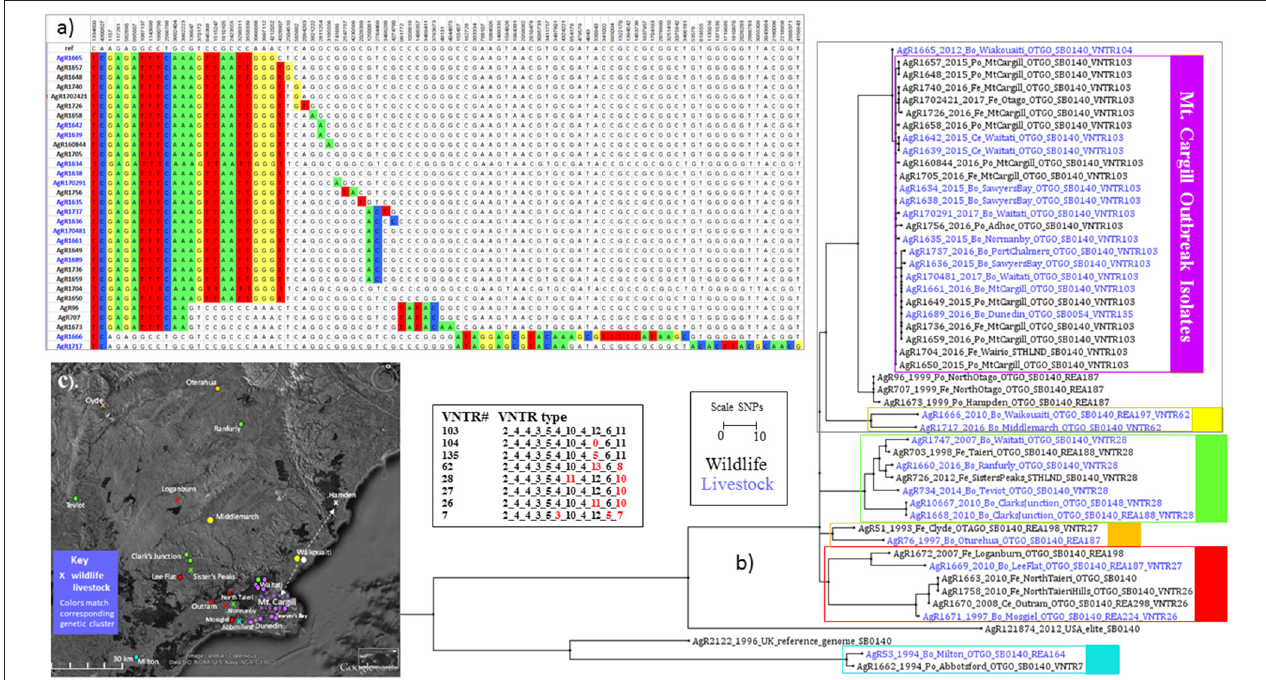
FIGURE 3 | Mt. Cargill Outbreak Investigation. Genetic and spatial relationship of M. bovis isolates from southeast Otago. (a) SNP table and Phylogram for selected isolates from the Otago cluster. The SNP table illustrates SNP differences in outbreak isolates and their closest known relatives. Chromosomal positions in genomic reference NC_002945.3 are listed across the top. The DNA base found at the indicated chromosomal position in the reference is listed in the next line. DNA bases in the table are colored to indicate differences from the reference genome. (b) Square ML Phylogram. The scale bar indicates the distance in SNPs between isolates displayed in the phylograph. Livestock metadata in the tree (_Bo_ for bovine _Ce_ for cervine) is colored blue and wildlife metadata (_Po_ for possum, _Fe_ for ferret), is colored black. The numbers for the listed VNTR types are the number of repeats at the 11 loci as described in Price-Carter et al. ( 15): Miru40_EtrD_EtrC_EtrE_NZ2_ QUB18_QUB11a_QUB26_DR2_DR1_QUB3232. Red numbers in this VNTR table indicate differences from the outbreak type VNTR103. (c) Map of sources of isolates shown in the phylogenetic tree in (b) . Symbols on the map indicate the approximate regional sources and are colored to match the genetic cluster of the isolate as indicated by the boxes in (b) . The arrows on the map in (c) indicate the proposed direction of the spread of this infection based on WGS